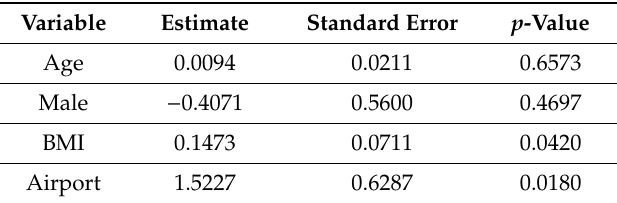
Table 10. Coe ffi cients for linear mixed models adjusted for age, sex, and BMI for the global Pittsburgh Sleep Quality Index (PSQI)